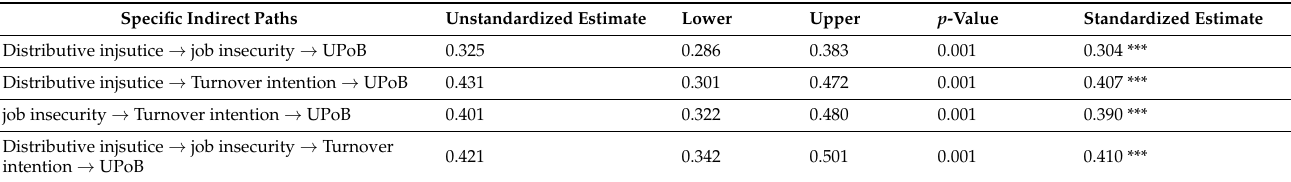
Table 5. Specific indirect